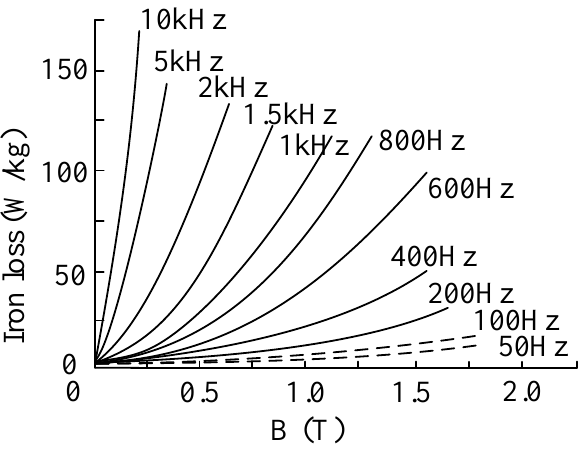
Figure 6. The loss curve of 35W270 at different